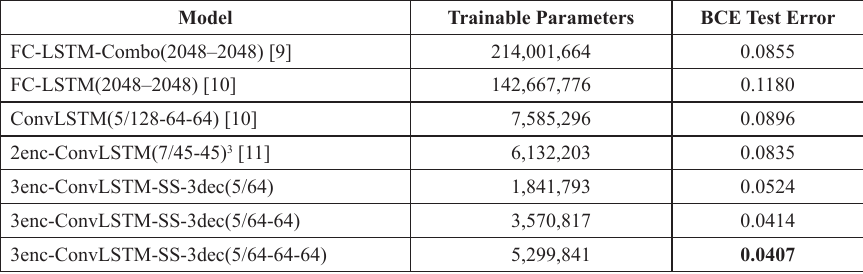
Table 1. Comparison with other networks on moving